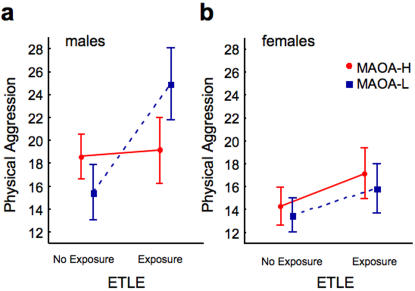
MAOA genotype moderates the association between early traumatic life events and physical aggression.Interactions between gender, MAOA genotype, and early traumatic life events (ETLE) predicted AQ-PA physical aggression scores in (a) males and (b) females. In the male group, carriers of the low, but not the high MAOA activity allele reporting exposure to early traumatic life events showed significantly greater physical aggression scores.